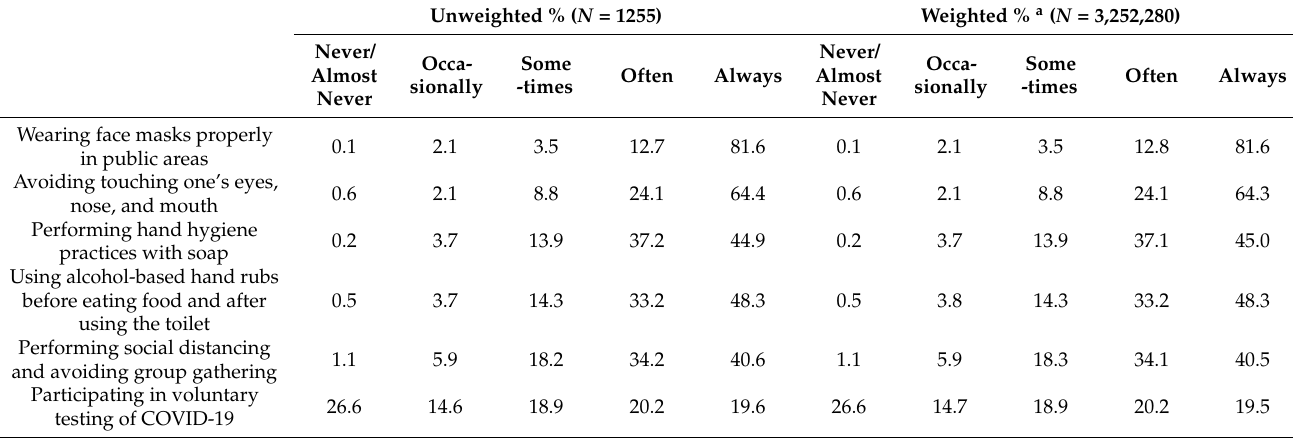
Table 2. Unweighted and weighted rates of adherence to